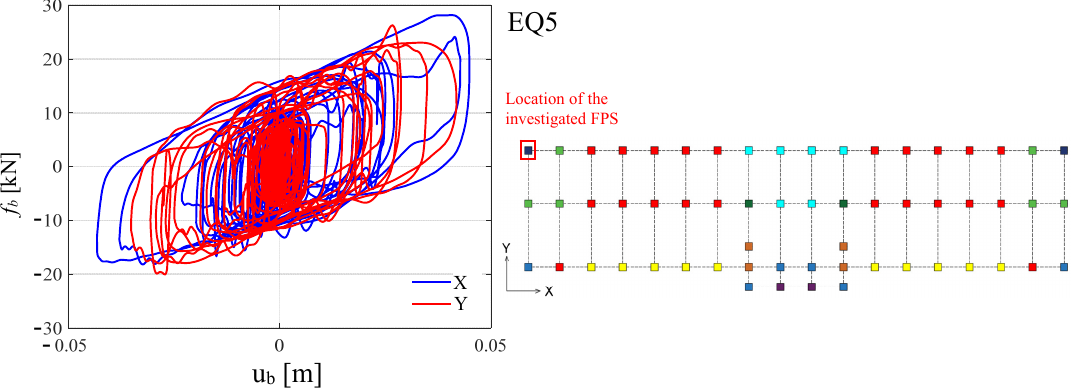
Figure 9. Hysteresis loops of the FP bearing under the motion of the EQ5 after scaling process.